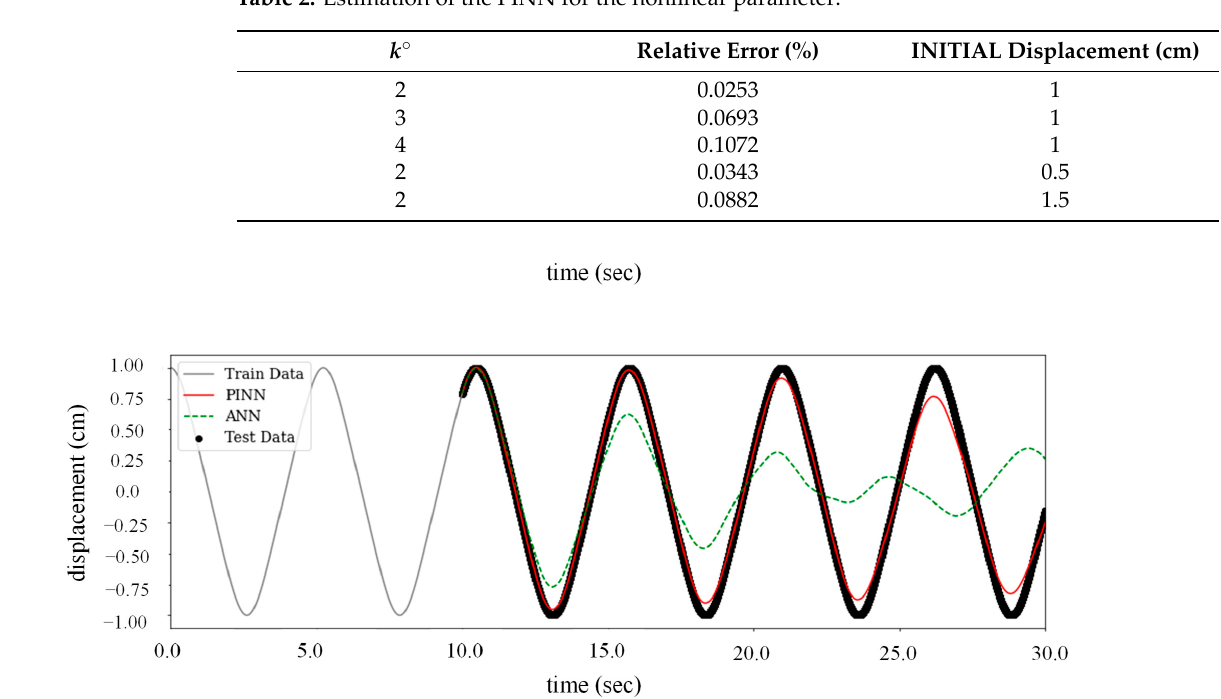
Figure 15. The PINN and ANN state estimation for the test period after two natural training periods.